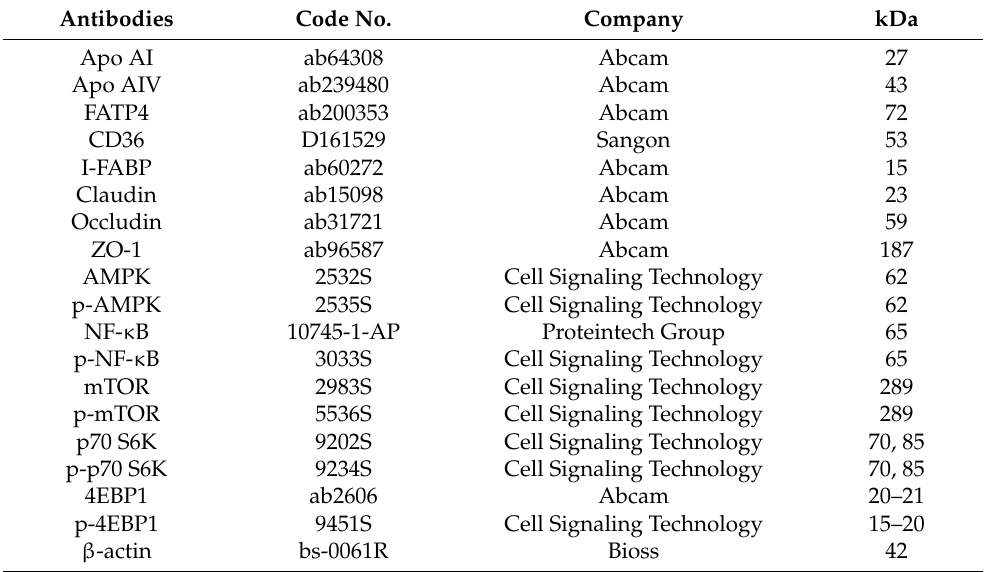
Table 2. Antibody information used in this